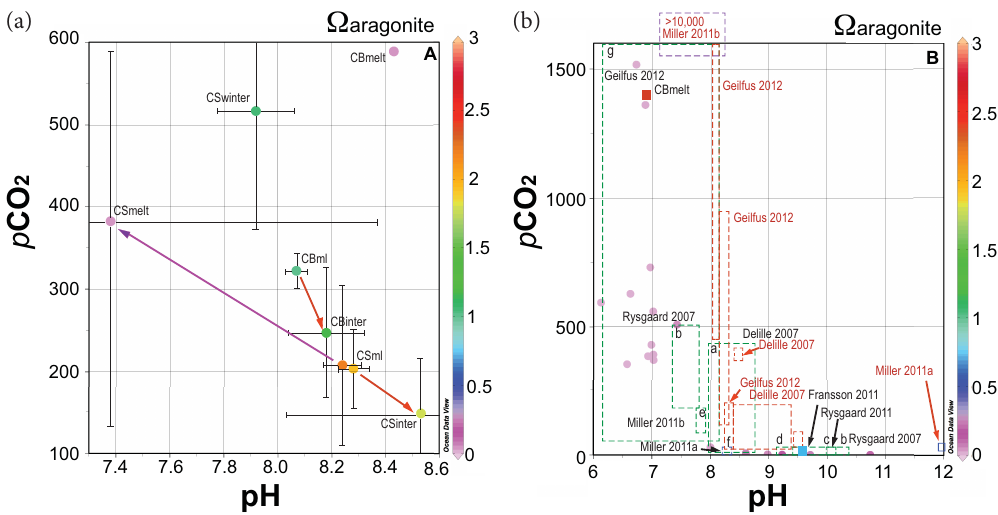
Figure 7. Scatter plot of above-ice and interface melt pond water pH against p CO 2 (µatm) with (cid:127) aragonite values from the 2010 and 2011 ICESCAPE sea-ice stations in the western Arctic Ocean. Panel (a) shows mean and standard deviation for data collected on the Chukchi Sea shelf and Canada Basin. CSml, CSinter, CSmelt denote mean CO 2 –carbonate chemistry for the mixed-layer, interface and above-ice melt pond water for the Chukchi Sea (CS), respectively taken from Table 2. Winter water mean and standard deviation are also shown in the figure (CSwinter). CBml, CBinter, CBmelt denote mean CO 2 –carbonate chemistry for the mixed-layer, interface and above-ice melt pond water for the Canada Basin (CB), respectively taken from Table 2. In panel (b) ranges of CO 2 –carbonate chemistry from the ICESCAPE cruise are compared against the approximate ranges of p CO 2 and pH directly observed or calculated from other studies (given in Table 1). The dashed boxes in the figure refer to the pH and p CO 2 ranges of each study with colours denoting melted sea-ice (blue – fall/winter values; green – spring/summer values) and brines (blue fall values; purple – winter; red – spring/summer). Papers given in black or red text refer to melted sea-ice and brine studies,